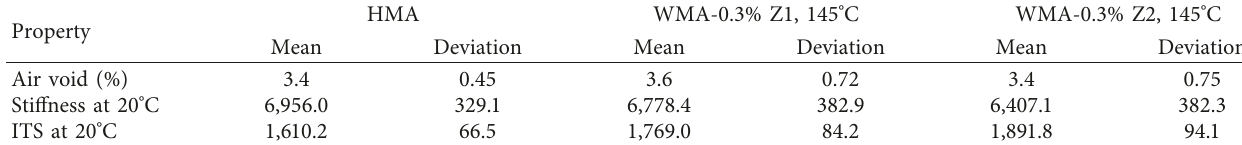
Table 5: Comparative summary of results from the workability